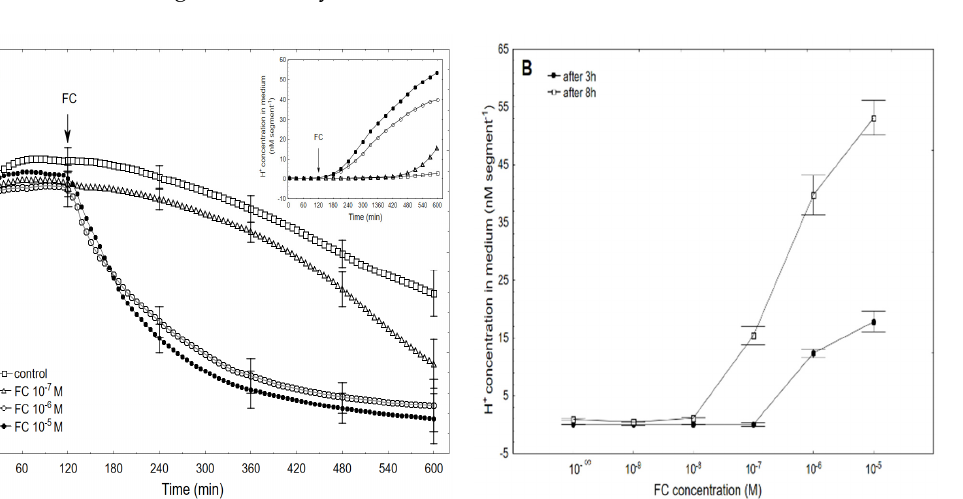
Figure 1. Growth rate (µm s − 1 cm − 1 ) of the maize coleoptile segments that had been incubated in the presence of 10 − 7 , 10 − 6 and 10 − 5 M of FC ( A ) and the dose–response curves for the FC (10 − 9 –10 − 5 M)-induced total elongation growth of the cole- optile segments as a function of time ( B ). The coleoptile segments were first preincubated (over 2 h) in a control medium to which FC had been added (arrow). The inset in Figure 1A shows the total elongation growth (µm cm − 1 ), which was calculated as the sum of the extensions from 3 min interval measurements over 10 h. All of the curves are the means of at least five independent experiments. Bars indicate ±